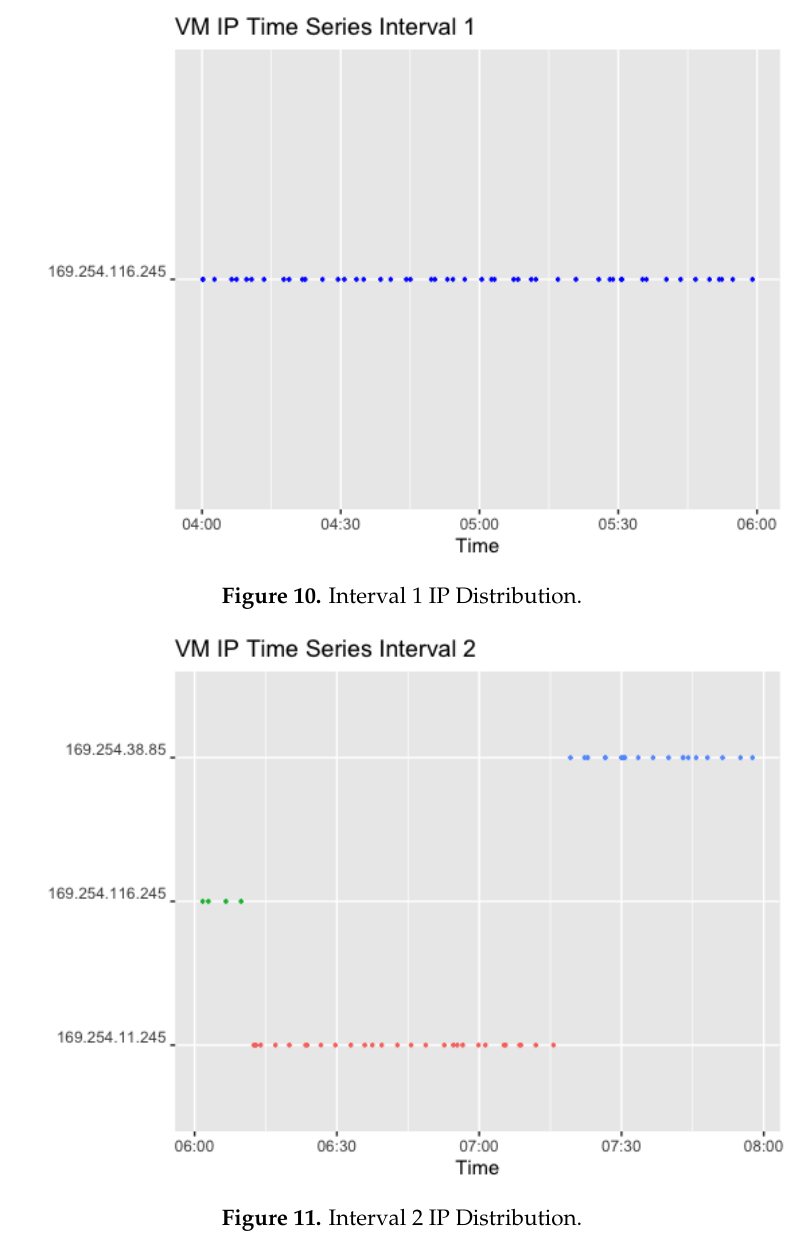
Figure 11. Interval 2 IP